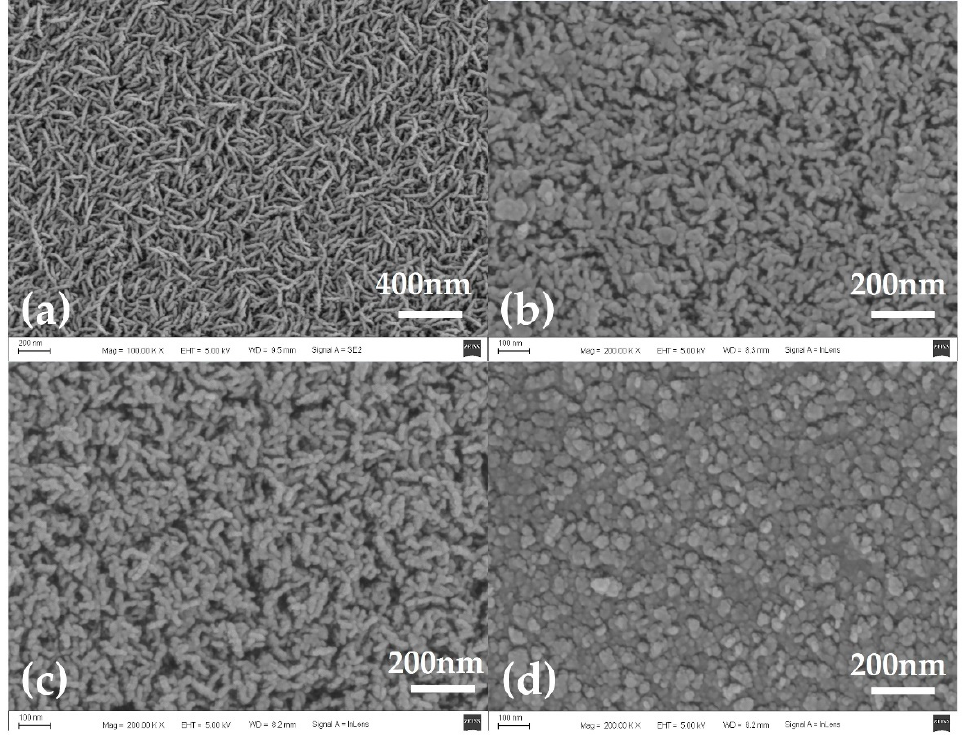
Figure 4. The surface morphology of iridium oxide films prepared at oxygen flow rates of ( a ) 10 sccm, ( b ) 20 sccm, ( c ) 30 sccm, and ( d ) 40 sccm; the Ar flow rate was maintained at 10 sccm during preparation, and the sputtering time was 15 min.